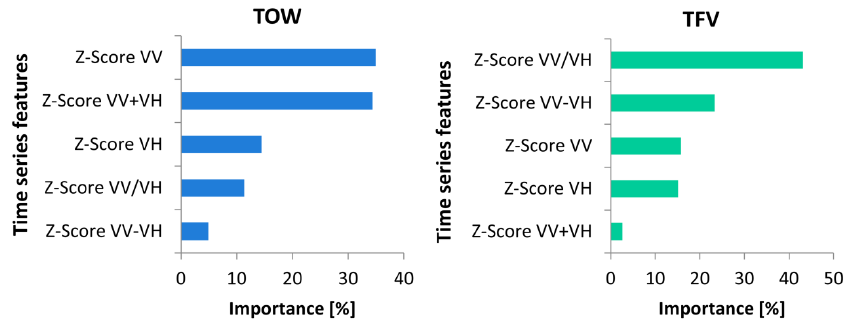
Figure 8. Importance of the time series features, which were determined by the Random Forest algorithm for TOW (blue bars) and TFV (green bars). The features are sorted by their highest to lowest importance.